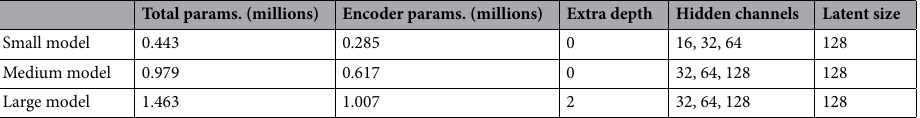
Table 2. Differences in the architecture for different proposed model sizes. Note that during inference, we only need the encoder network of the VAE model. We also only need to process the newly acquired image to obtain their latent representation, while the latent vectors of the previous image can be